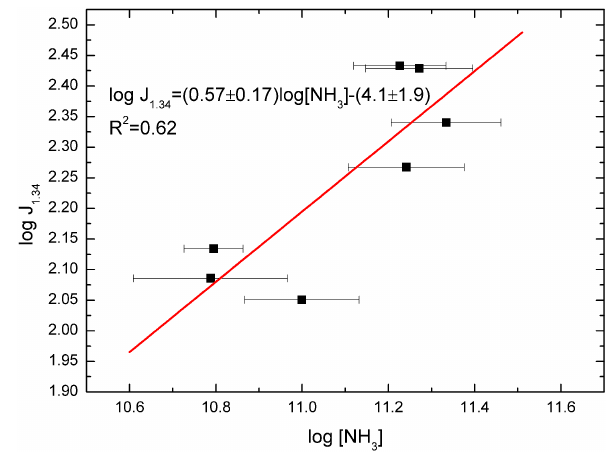
Figure 4. Correlation between log J 1 . 34 and log [ H 2 SO 4 ] . Daily peak concentration of sulfuric acid proxy was used as an approx- imation for its effective concentration on a NPF day. The error bar corresponds to a 42% uncertainty of sulfuric acid proxy according to Mikkonen et al. (2011).